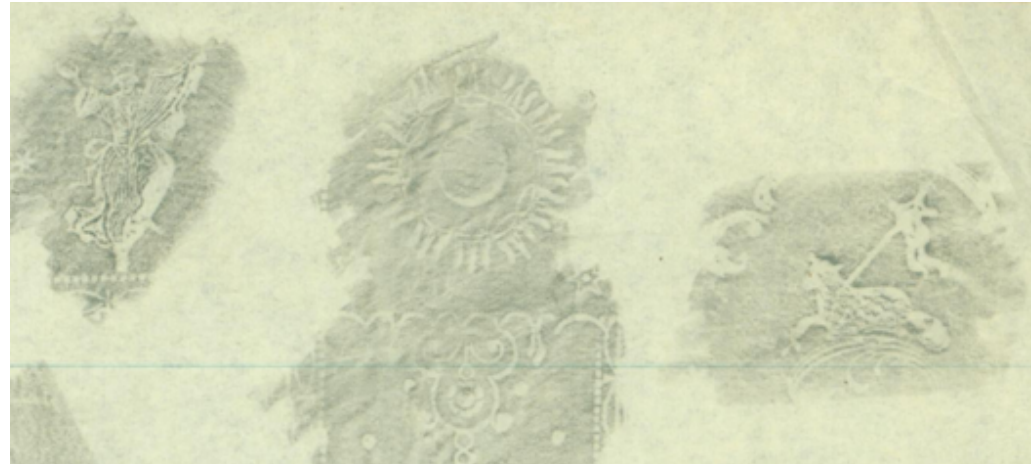
Fig. 25a. Rubbing (enlarged) of motifs of King David with harp, the sun with rays, the Lamb of God with pennant, from a Bible (Oxford, 1769) (location unknown). Copyright © The British Library